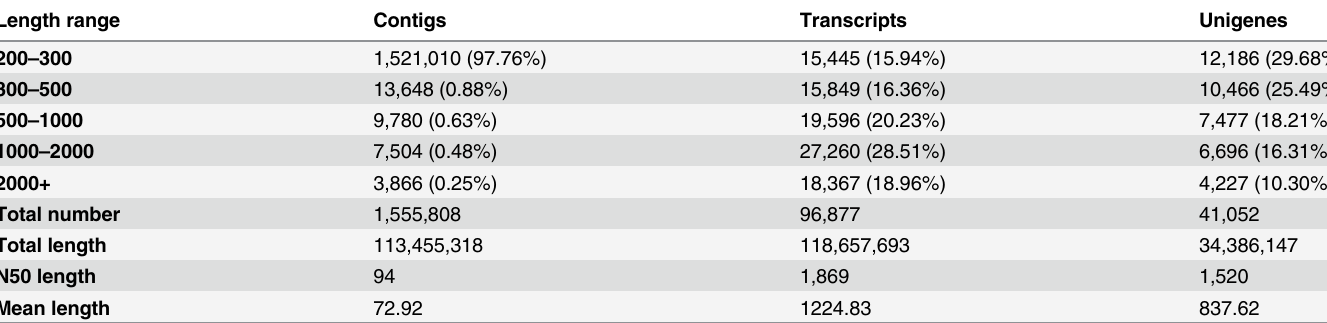
Table 1. Summary of Illumina transcriptome assembly for A . comosus var. bracteatus .